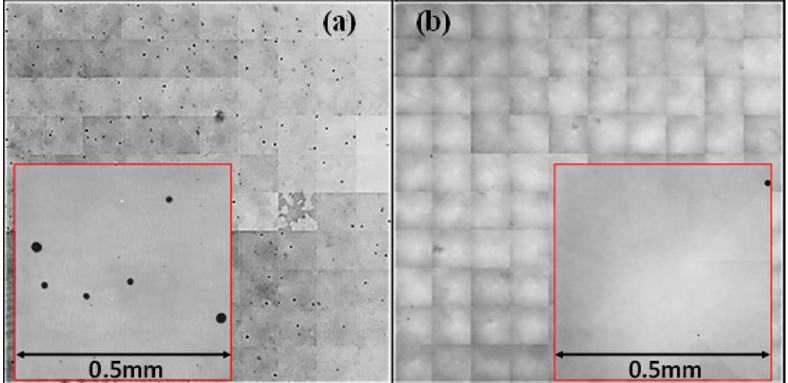
Figure 8. IR images for CRY-3, 5 × 5 mm 2 wafer, ( a ) as grown with big inclusions and ( b ) Wafer after the annealing. Insets show a 0.5 × 0.5 mm 2 area, where big inclusions in ( b ) are annealed out.